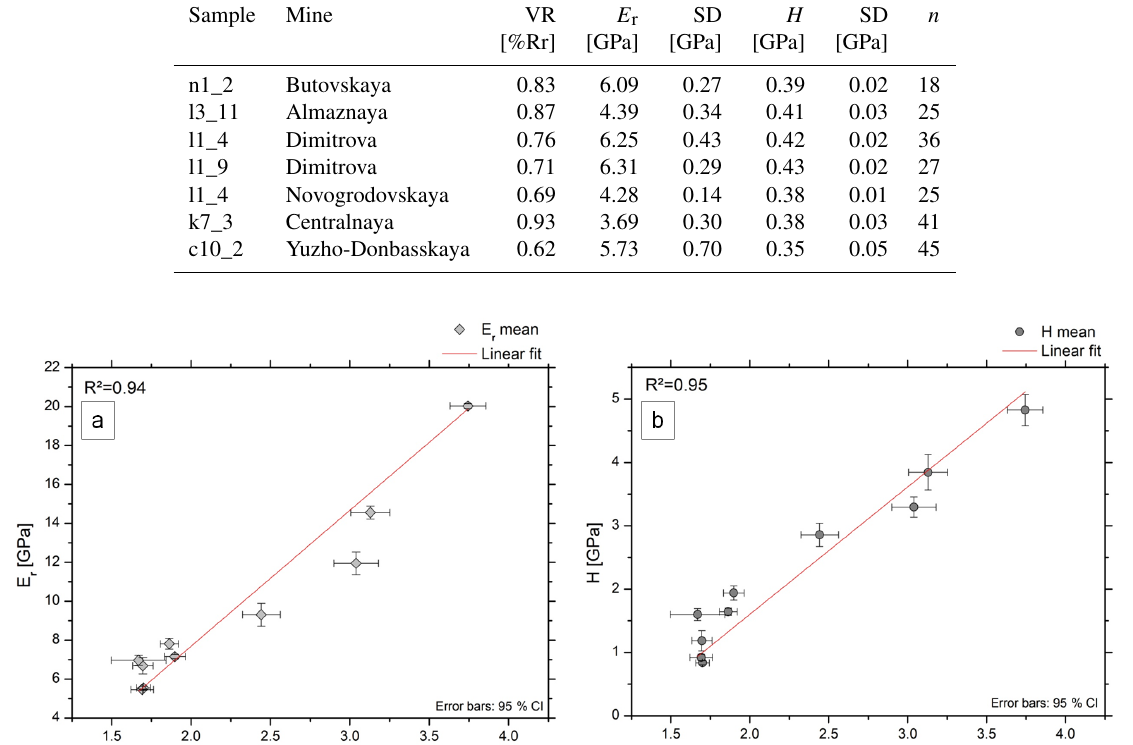
Figure 6. E r (a) and H (b) obtained for inertinites with varying IR (inertinite reflectance). (CI = Confidence interval).